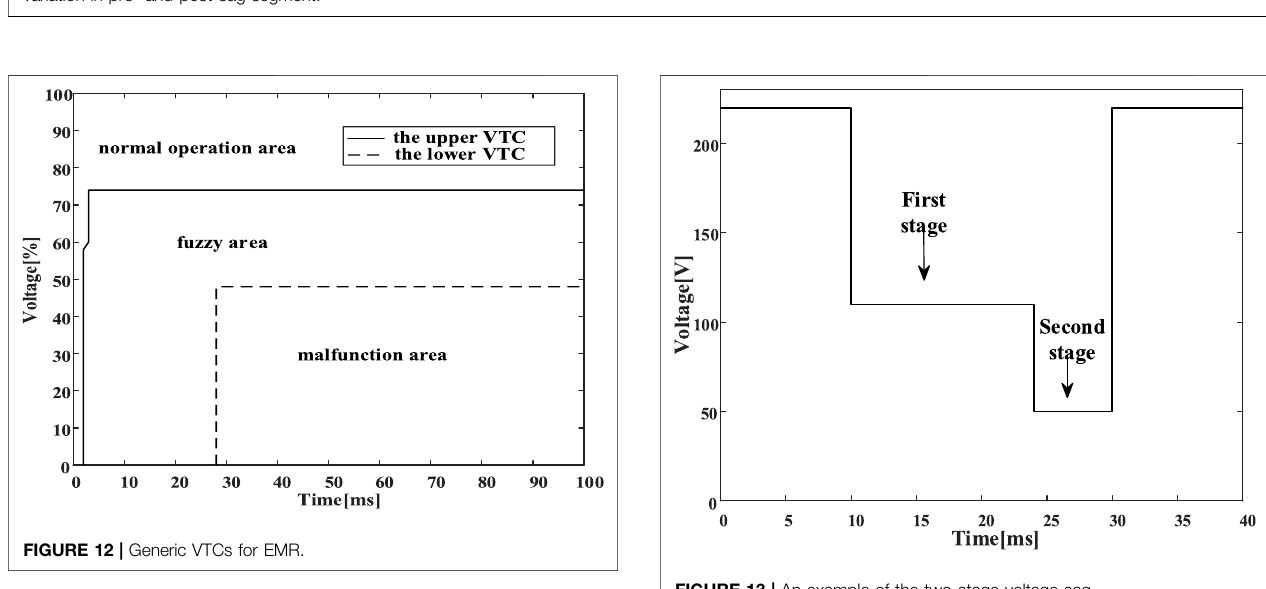
FIGURE 13 | An example of the two-stage voltage